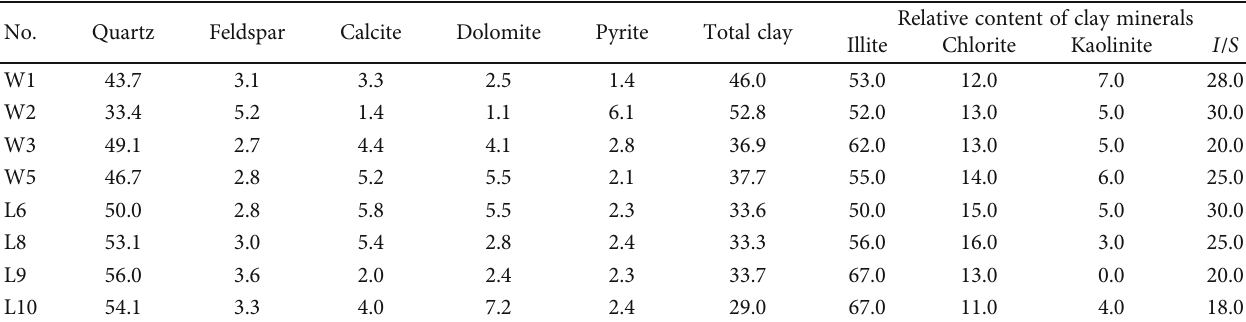
Table 4: Mineralogical composition of these deep shales based on XRD analysis (%).